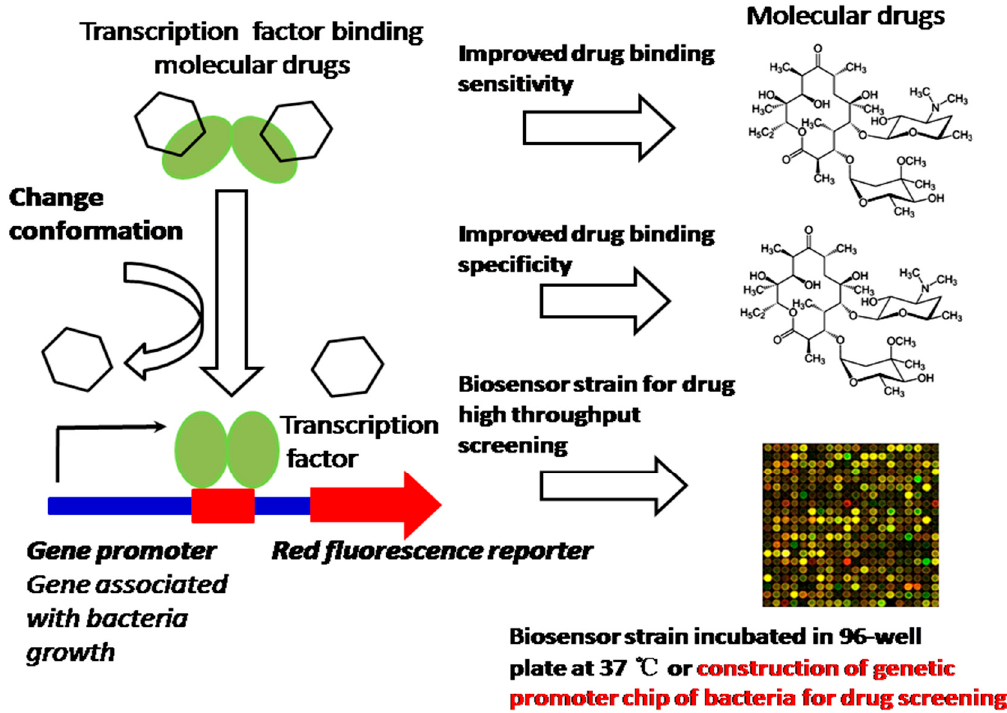
Figure 3. Construction of biosensor strain and genetic promoter chip of bacteria for high-throughput screening (HTS) transcription factor (TF)-acting molecular drugs.